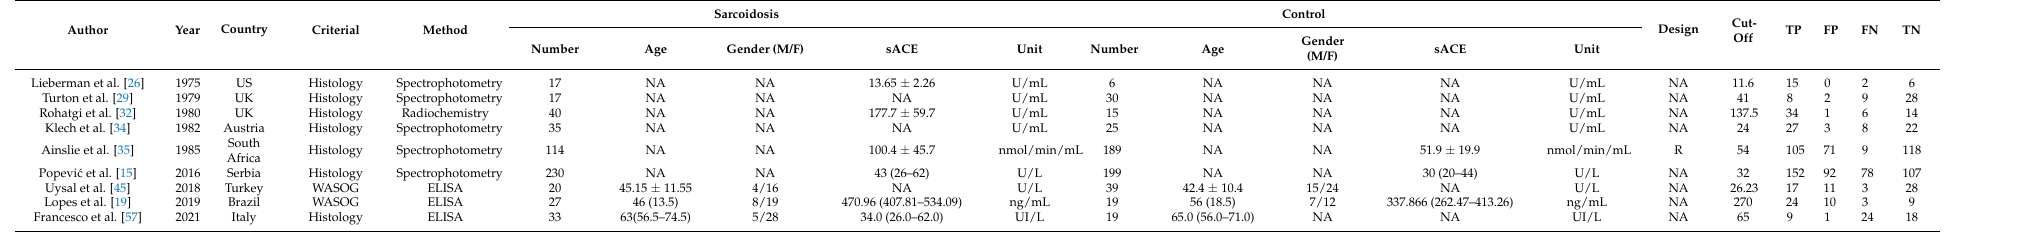
Table 2. The clinical summary of included studies for active status of